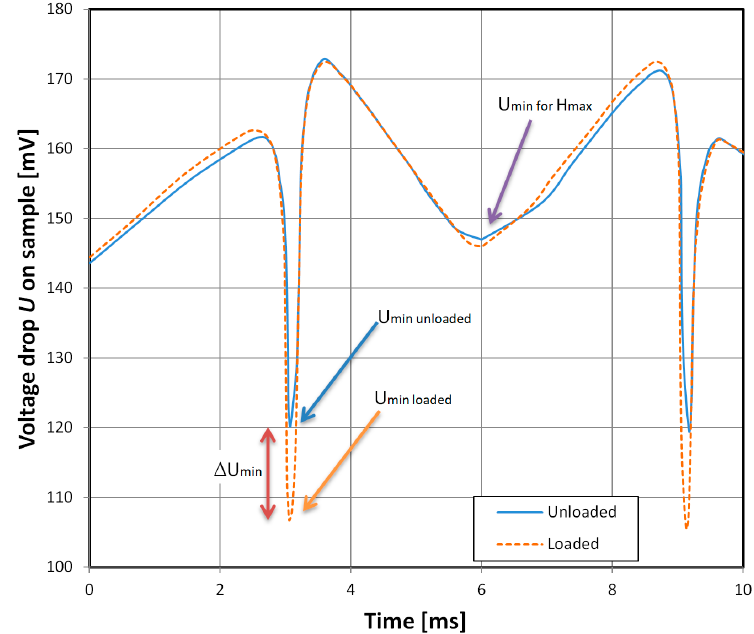
Figure 4. Measured HF voltage drop U signal for a 5 MHz, 400 mV RMS driving signal. The minimum of the voltage drop signal U min (corresponding to arrows in Figure 3b) is the strain-dependent part of the measured waveform.